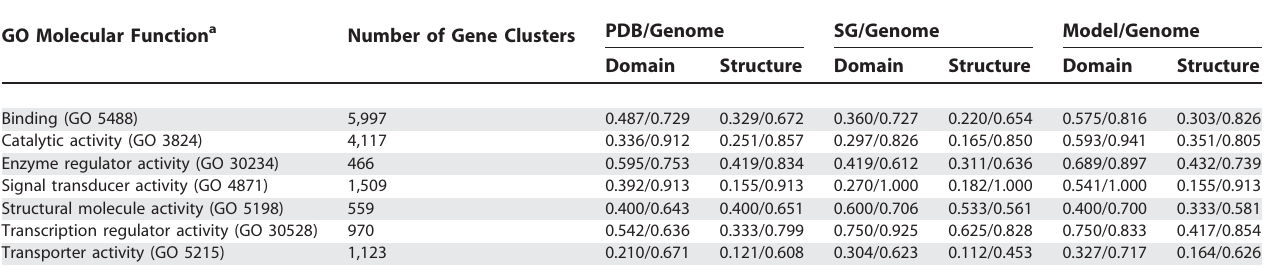
Table 2. Coverage/Kendall’s Tau Correlations for Major Categories of GO Molecular Function for Both Single Domains and Whole